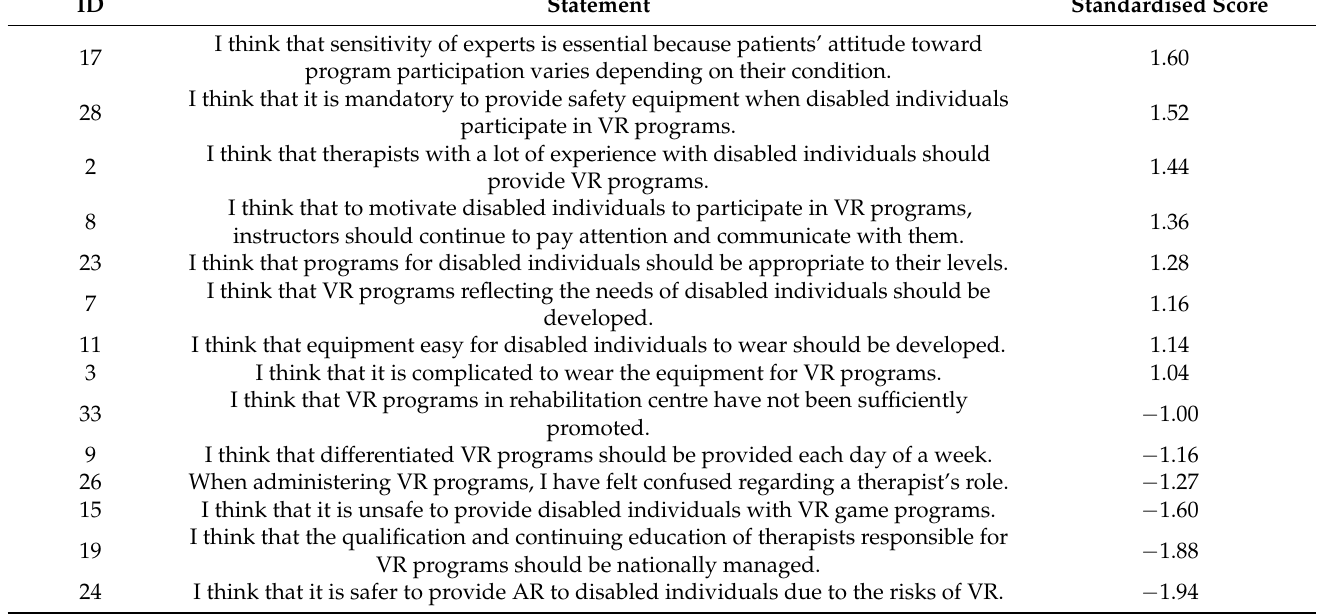
Table 7. Type 2 statements and standardised scores ( ± 1.00 and